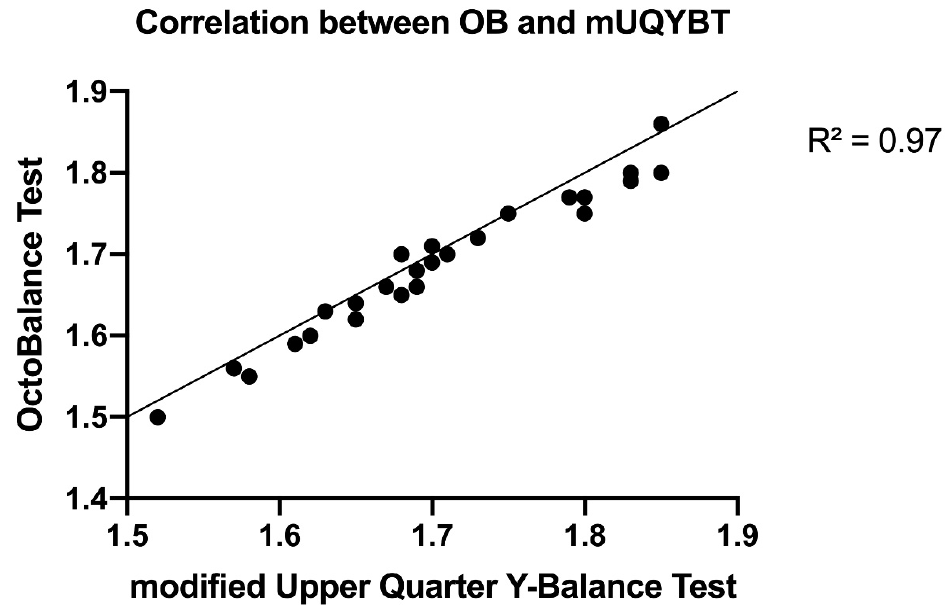
Figure 6. Logarithmic correlation between OB (cm) and mUQYBT (cm).